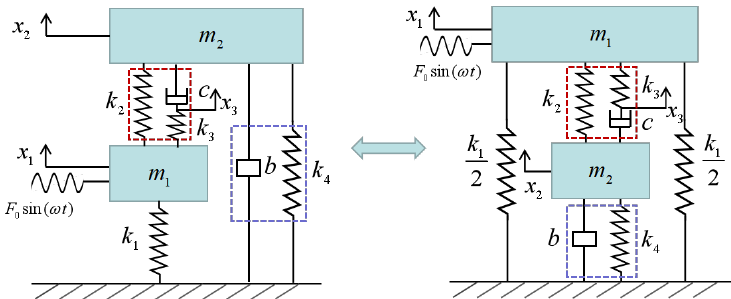
Figure 1. The viscoelastic Maxwell-type DVA with an inerter and multiple stiffness